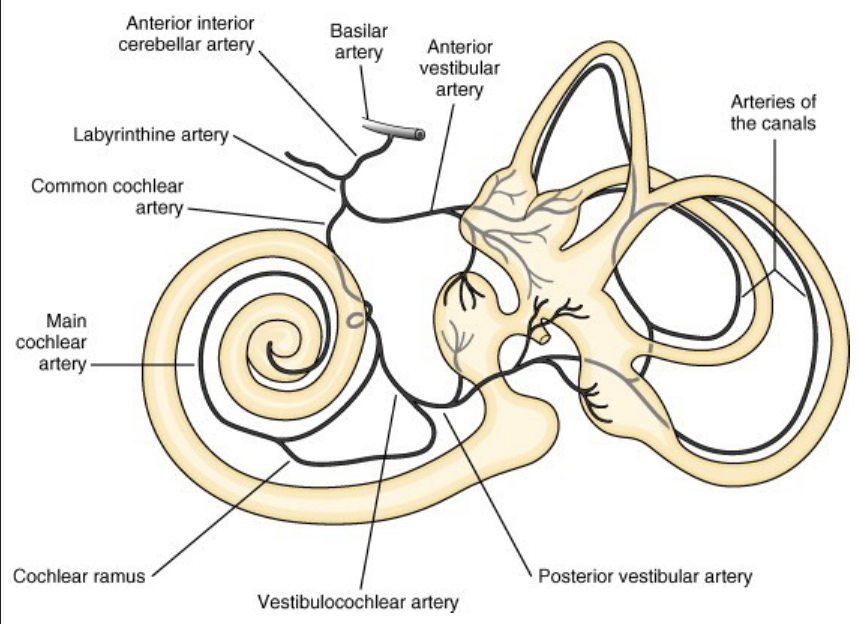
Figure 1. Arterial supply of the inner ear. (From Schuknecht HF: Pathology of the Ear. Philadelphia, Lea &amp; Febiger, 1993, p 64.) Copyright© 1993 Philadelphia, Lea &amp;